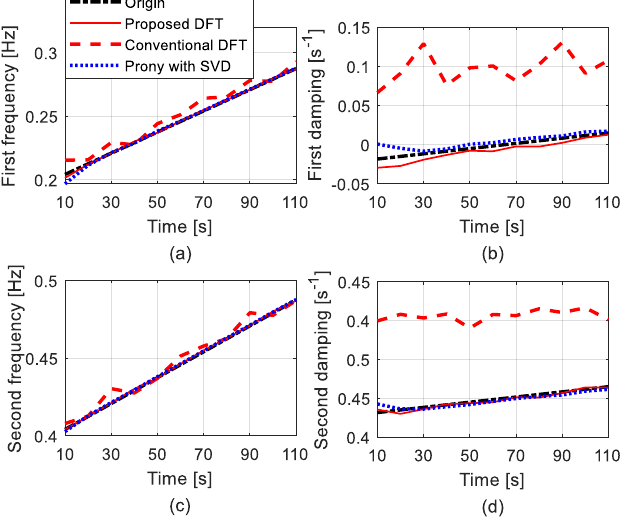
Figure 4. Estimated modal parameters in the simulation with a 50 dB SNR: ( a ) oscillation frequency of the first mode; ( b ) damping factor of the first mode; ( c ) oscillation frequency of the second mode; ( d ) damping factor of the second mode.